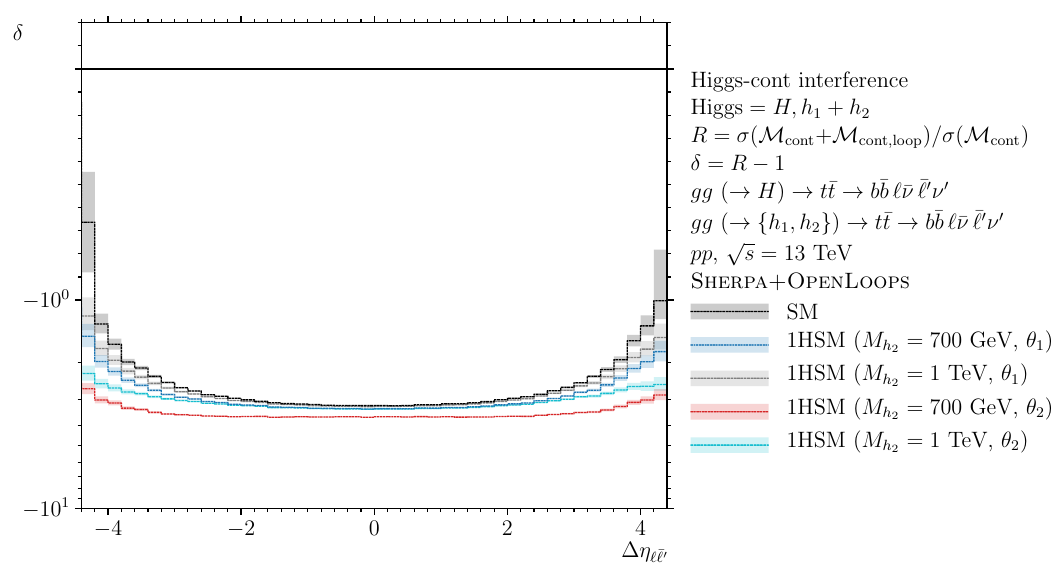
Figure 24 . ∆ η distributions of the relative deviation δ = R (cid:31) ¯ (cid:31) (cid:31) background without and with the virtual corrections in the SM and 1HSM ( M h ) for gg ( H, h 1 , h 2 ) t ¯ t b ¯ b (cid:20) ¯ ν ¯ (cid:20) (cid:31) ν (cid:31) in pp collisions at √ s = 13 TeV. Other details as θ 1 , θ 2 } → { } → → { in figure 22.